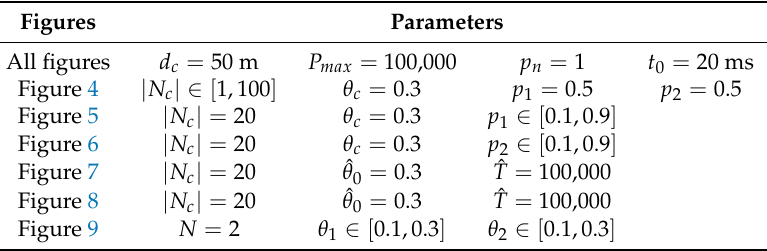
Table 3. Parameters of the evaluations.